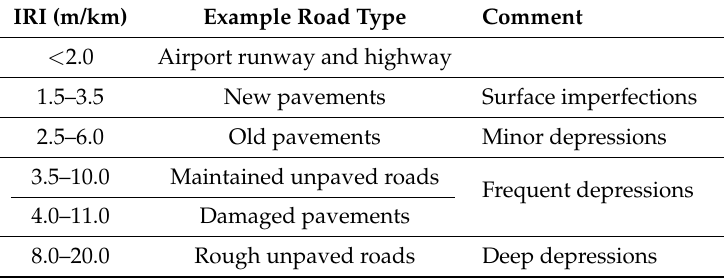
Table 2. Typical road roughness conditions of various roads in terms of the International Roughness Index (IRI)